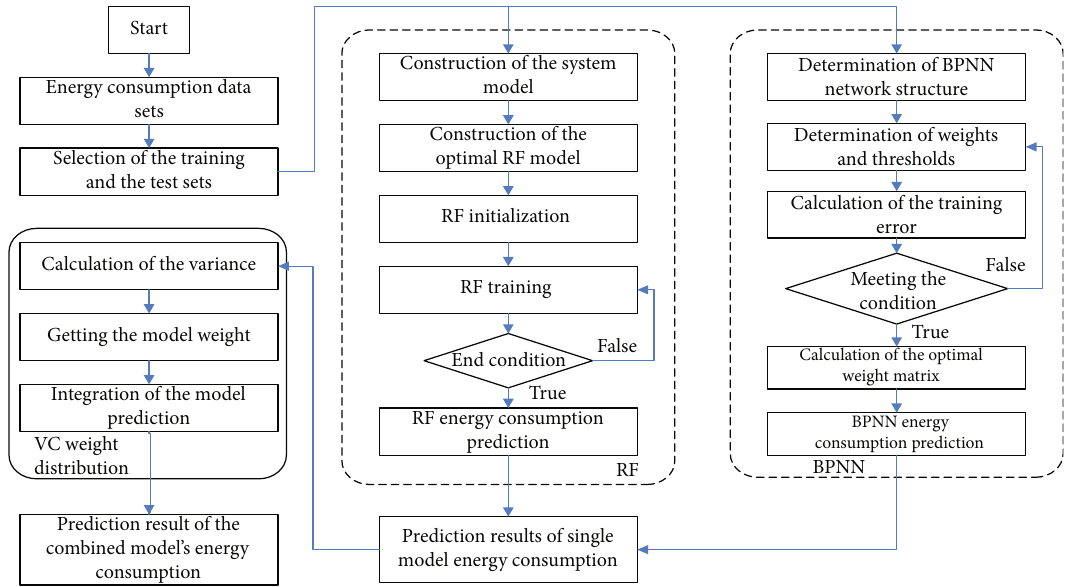
Figure 1: RF-BPNN energy consumption prediction fl owchart.